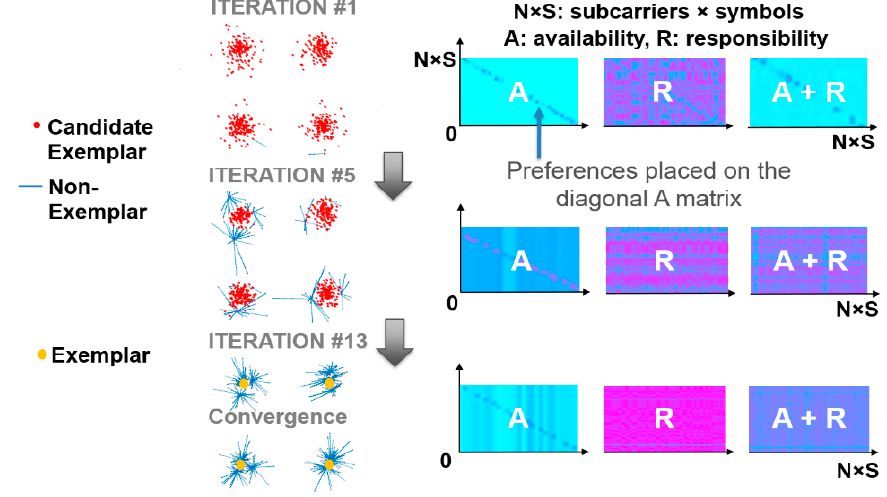
Figure 8. Affinity propagation (AP) clustering procedure (e.g., quaternary phase ‐ shift keying (QPSK)) [36].